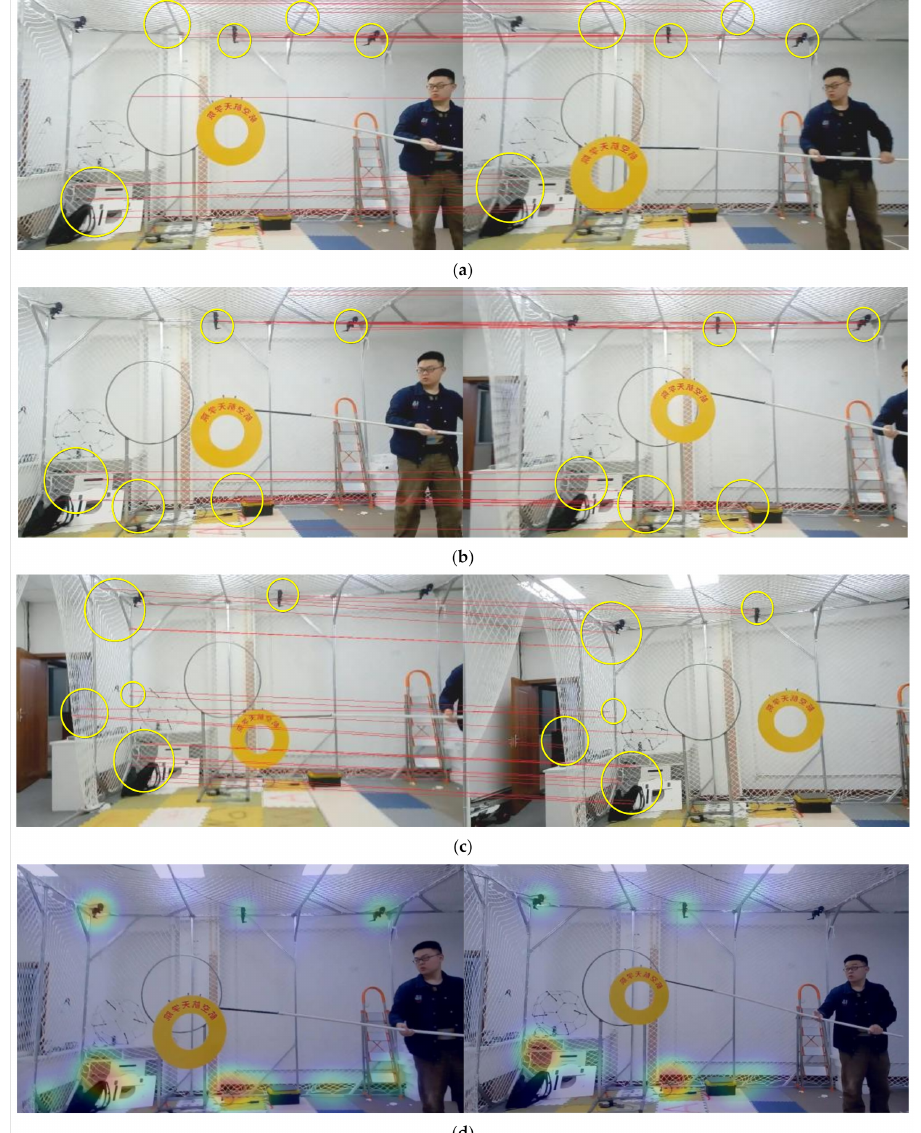
Figure 15. The schematic diagram of extracting orb feature point matching under the domain constraint of the Level 2 self-supervised feature area (the yellow circle area): ( a – c ) shows two sets of orb feature point matching under the constraints of the Siamese network feature matching area. ( d ) The attention heatmap of two different frames in the mobile